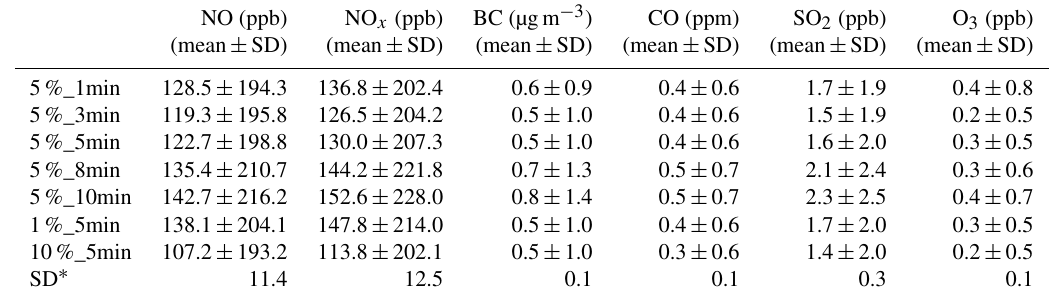
Table 4. The mean on-road emission concentrations estimated using the moving low-percentile method (MLPM) for NO, NO x , BC, CO, SO 2 , and O 3 with different time windows (i.e. 1–10min) and percentiles (i.e. 1%, 5%, and 10%).